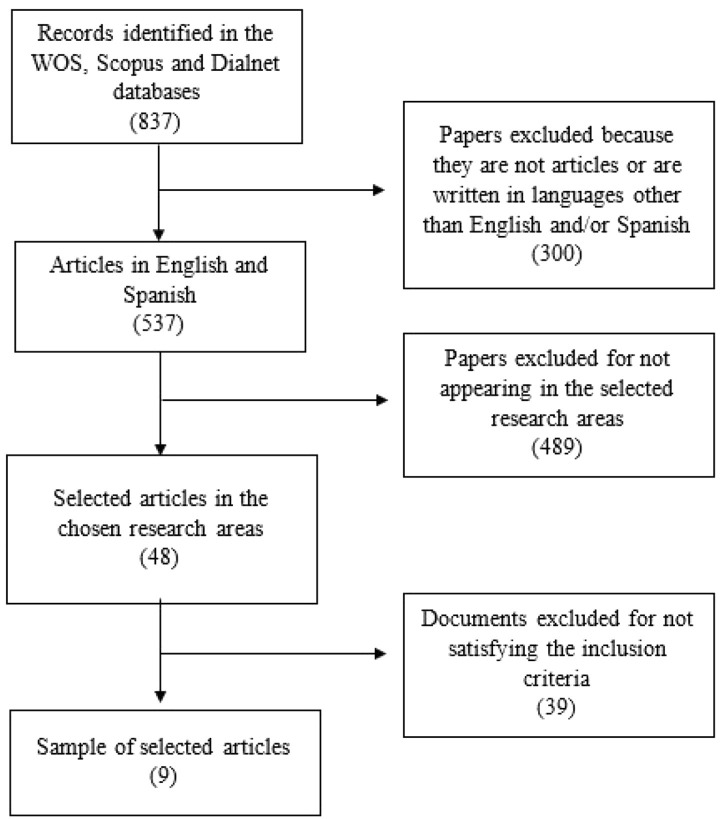
PRISMA flowchart.